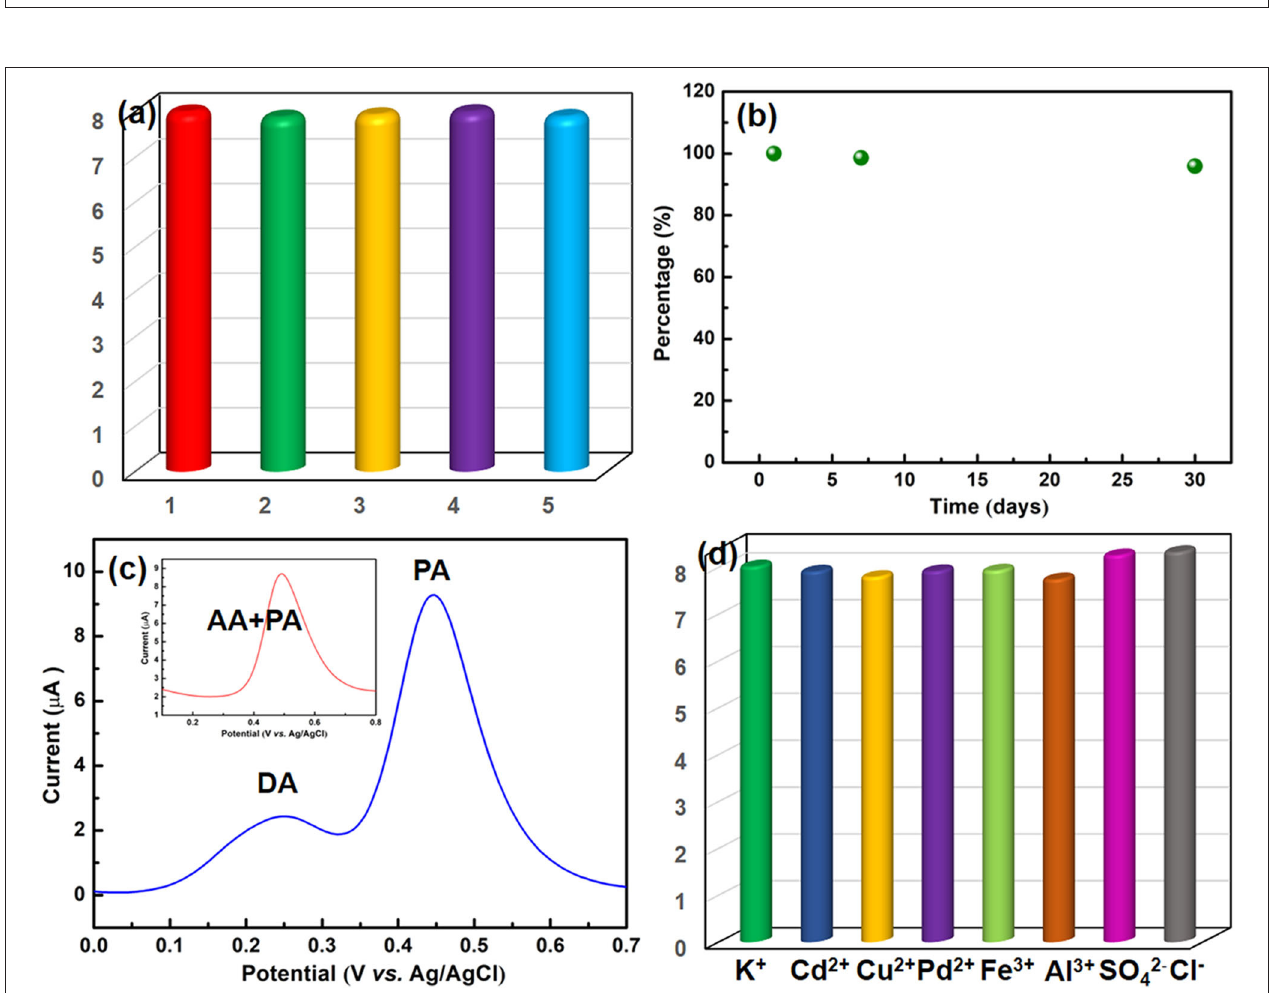
Frontiers in Chemistry |